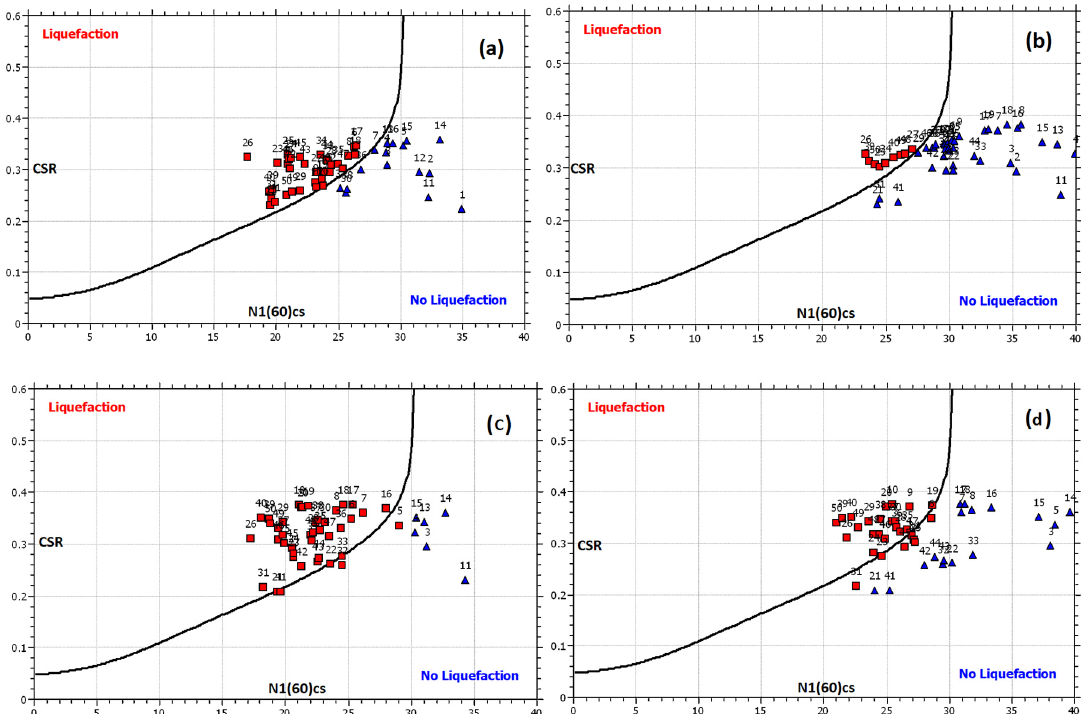
Figure 8. SPT-based liquefaction analysis of clean sand for σ (cid:2973)(cid:2868)՛ = 100 KPa and CRR M = 7.5 , following NCEER recommendations for: ( a ) Liquefaction assessment before jet grouting, ( b ) liquefaction evaluation after jet grouting using micropiles and according to Eurocode 8, ( c ) liquefaction assessment